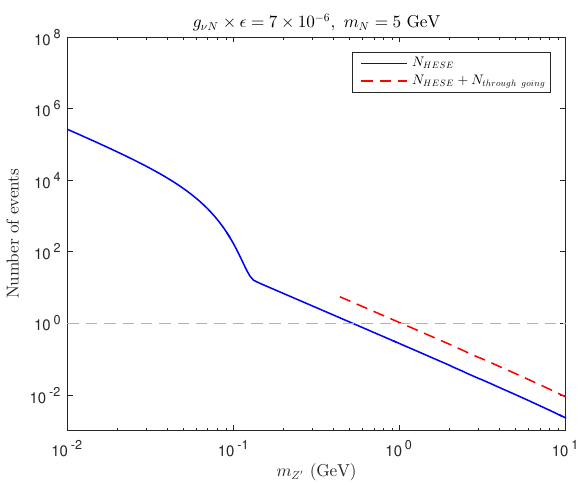
Figure 1 . Number of new physics events at FASER ν during LHC run III vs. m Z 0 . The solid blue line shows the number of N produced inside the detector ( N HESE ). The red dashed line shows the total number of the µ ¯ µµ ¯ µ events coming from the production of N both inside the detector and en- route rock and concrete ( N HESE + N through-going ). The line is clipped at m Z 0 = 4 m µ because below this value, the µ ¯ µµ ¯ µ signal cannot be created. We have set m N = 5 GeV and g νN × (cid:15) = 7 × 10 − 6 and have taken the flux of neutrinos from figure 4 of [1]. The cyan horizontal dashed line corresponds to the number of events equal to